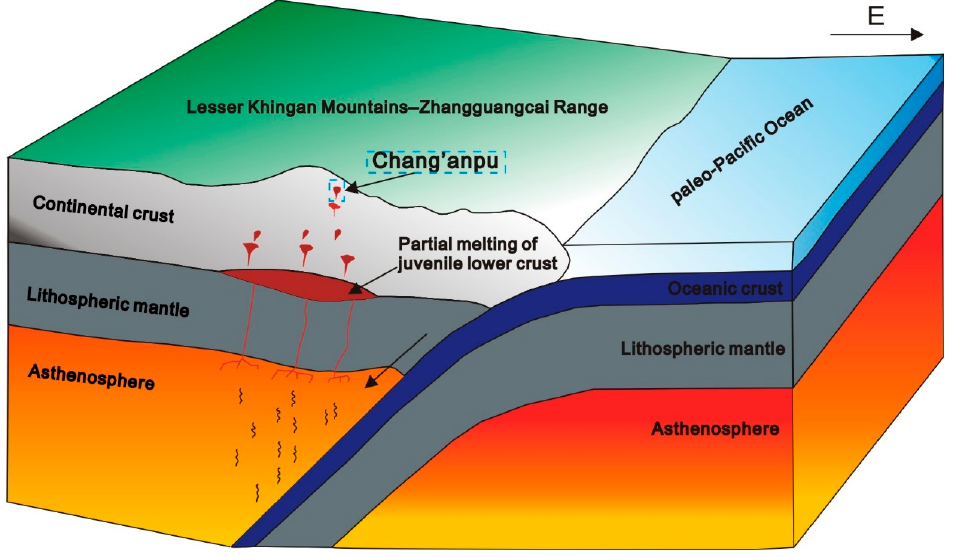
Figure 11. Diagenetic and metallogenic model of Early–Middle Jurassic porphyry deposit (modified after Guo et al. (2015)